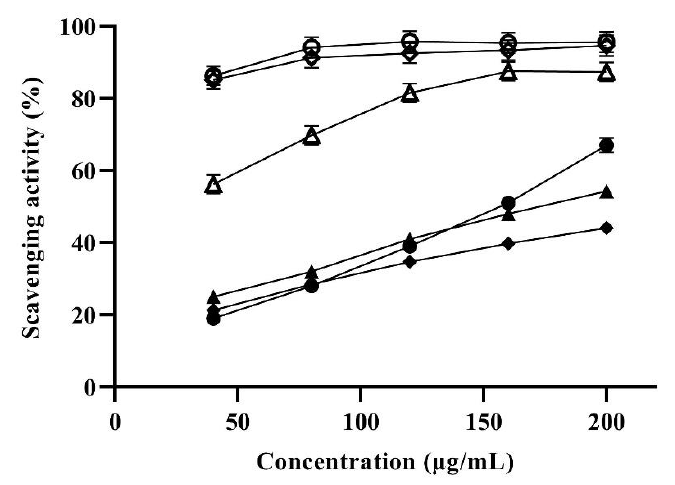
Figure 5. In vitro antioxidant activity of lutein from G. rubripertincta GH‑1 using ascorbic acid (Vc) as reference. The # , △ and 3 indicate the DPPH radical, hydroxyl radical and superoxide radical scav‑ enging activity of Vc reference, respectively. The , ▲ and u indicate the DPPH radical, hydroxyl radical and superoxide radical scavenging activity of lutein, respectively.